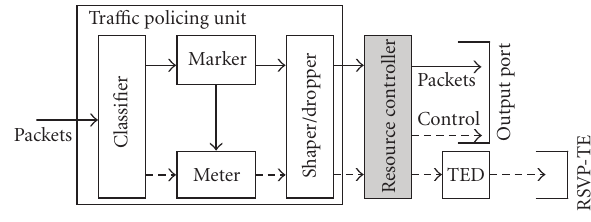
Figure 8: The structure of the ingress MPLS node.